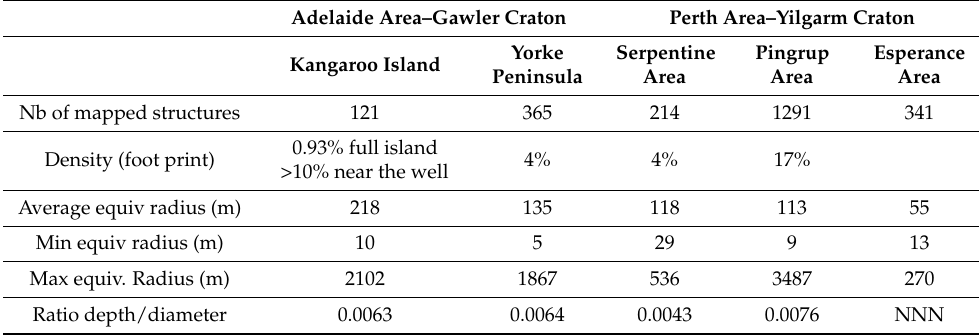
Table 3. Comparison of the characteristics between the 5 mapped areas in